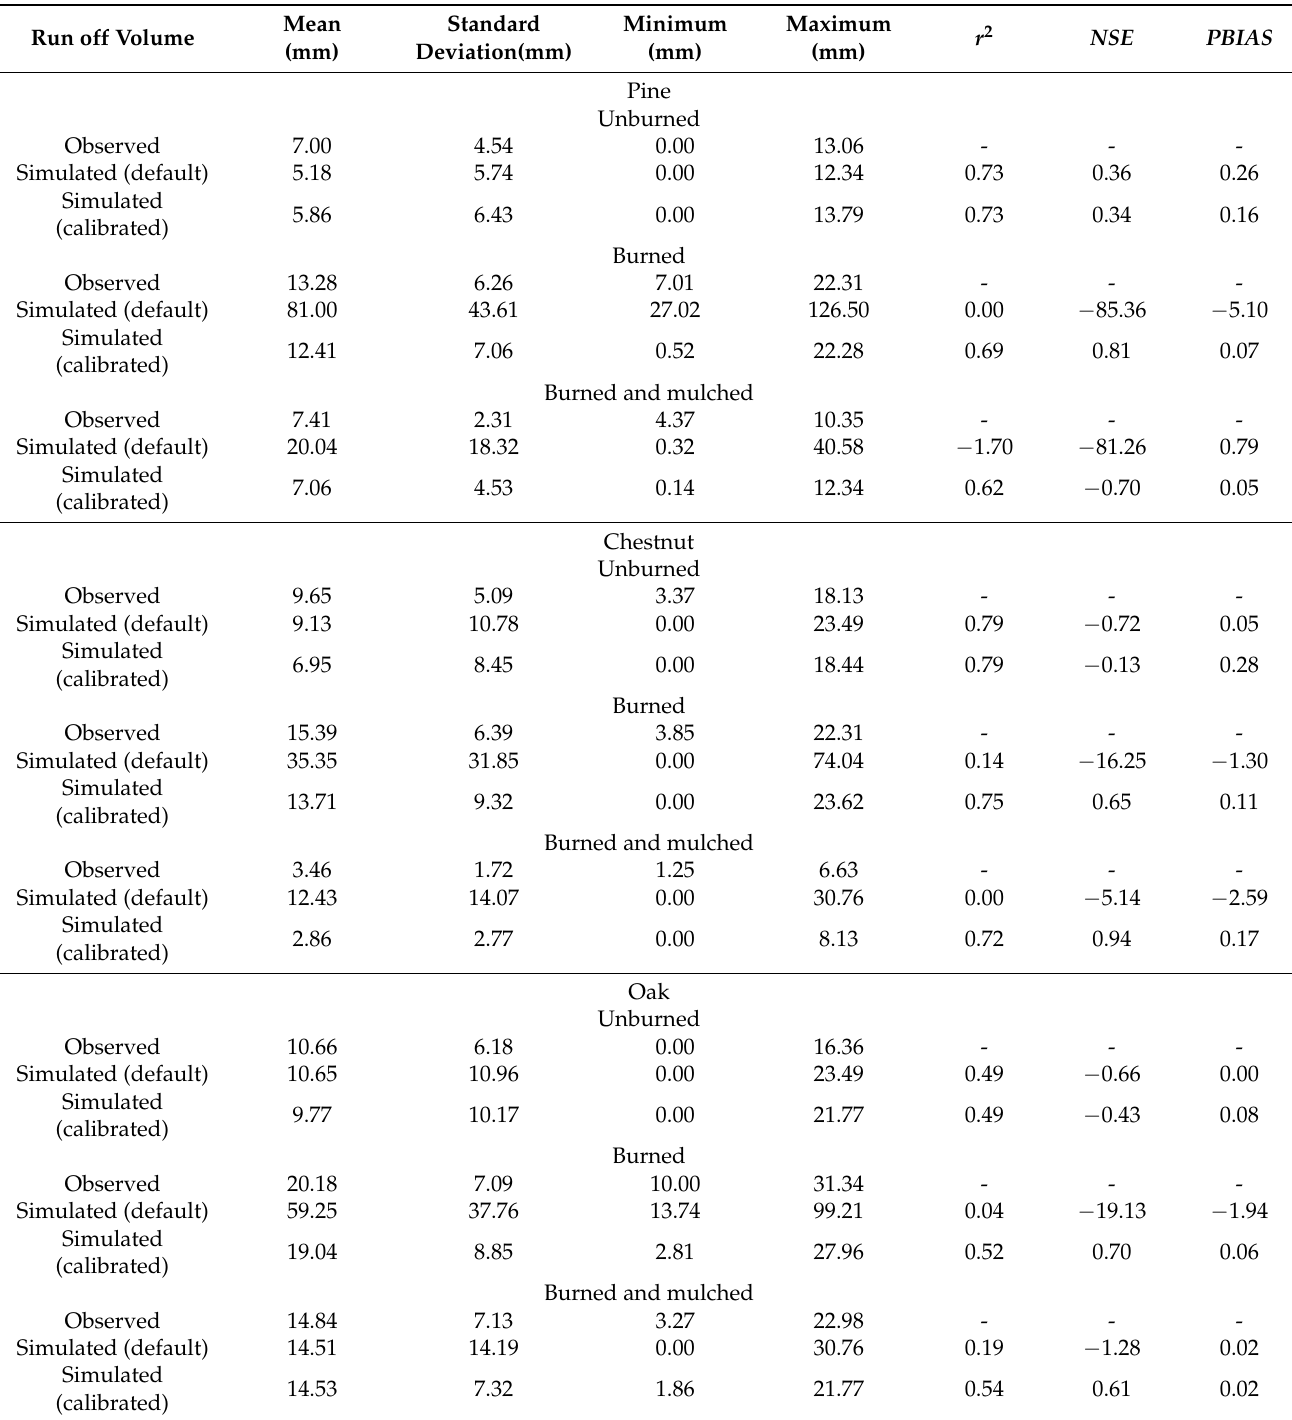
Table 3. Statistics and indexes evaluating the runoff prediction capability of the SCS-CN model in forest plots subject to prescribed fire and soil mulching with